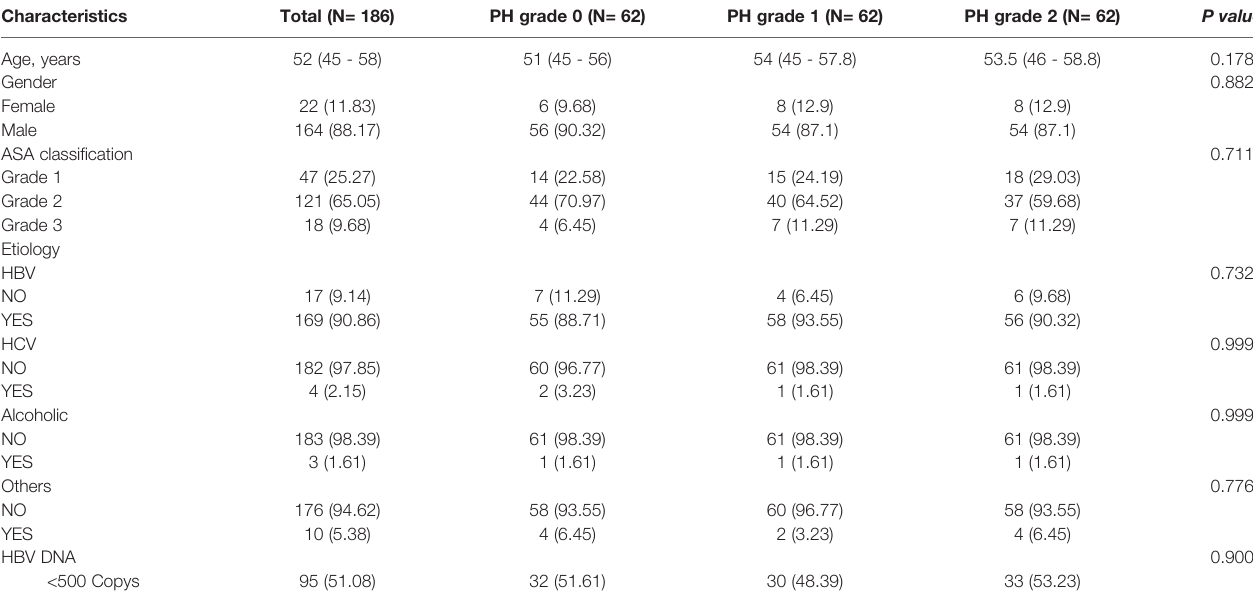
TABLE 3 | Comparisons of Characteristics between different portal hypertension grades after Propensity Score Matching.